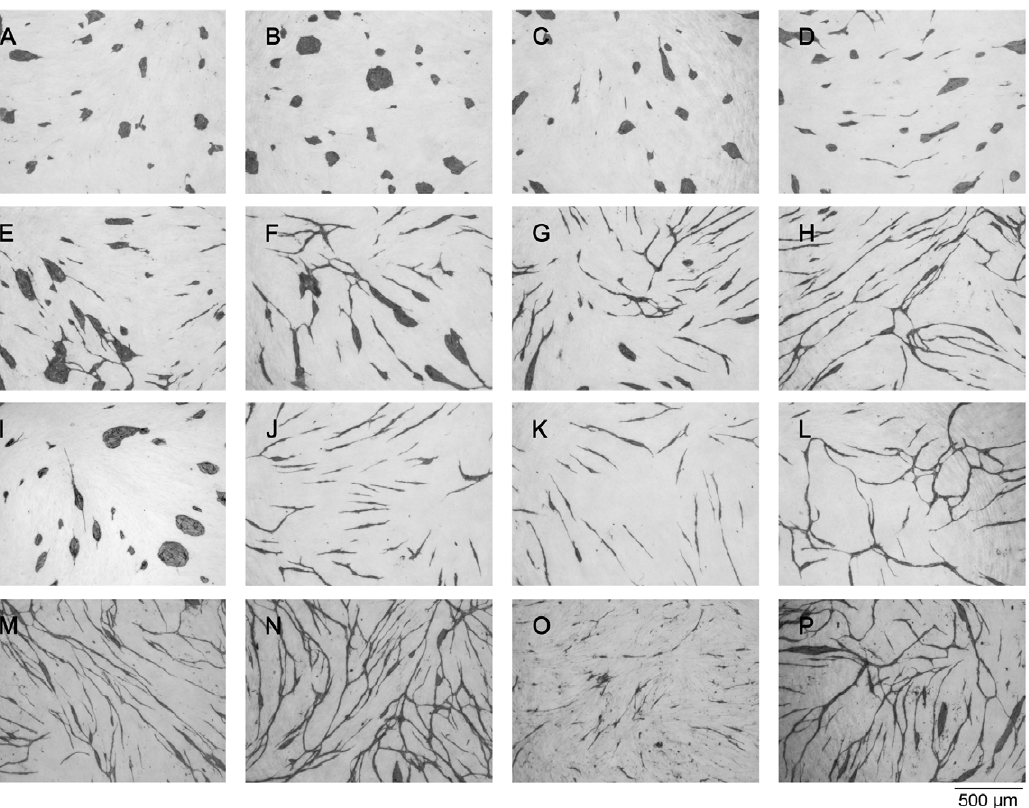
Figure 6. The effect of anti-VEGF and various concentrations of N-methyllevamisole (7a) and suramin (5) recorded in the in vitro angiogenesis assay performed with HUVECs growing on a fibroblast monolayer. The images show HUVECs visualized by immunostaining for CD31 after treatment with: A) 1 mM N -methyllevamisole triflate (7a); B) 0.5 mM N -methyllevamisole triflate ( 7a ); C) 0.25 mM N -methyllevamisole triflate ( 7a ); D) 0.13 mM N -methyllevamisole triflate ( 7a ); E) 0.06 mM N -methyllevamisole triflate ( 7a ); F) 0.03 mM N -methyllevamisole triflate ( 7a ); G) 0.02 mM N -methyllevamisole triflate ( 7a ); H) 0.1 % DMSO (the control was diluted 1:1000 corresponding the concentration of DMSO present in A); I) 5 m g/mL goat anti-recombinant human VEGF; J) 12 m M suramin ( 5 ); K) 1.5 m M suramin ( 5 ); L) medium (control); M) 10 mM BIS-TRIS; N) 10 mM BICINE; O) 10 mM N -methylimidazole; P) 1 mM N -methylimidazole.